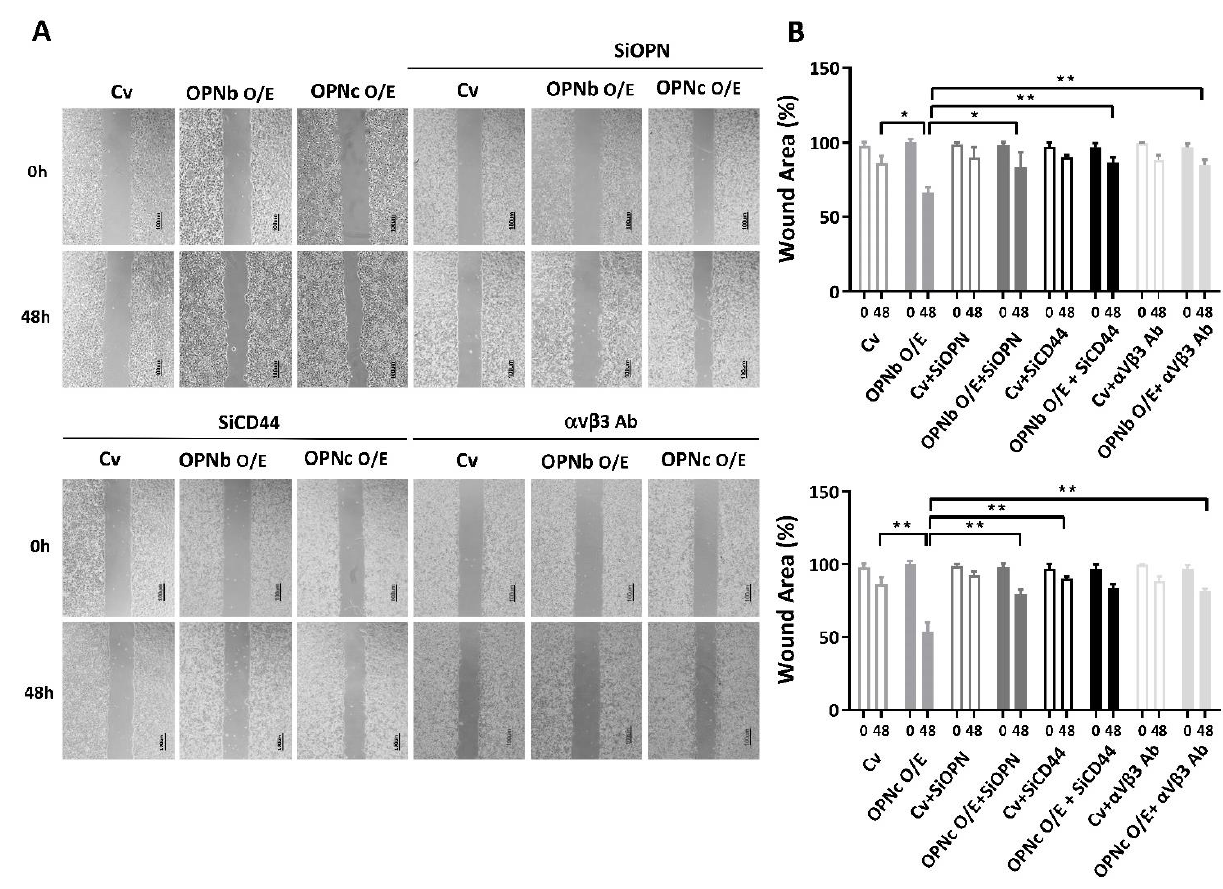
Figure 6. The effect of OPN isoforms on HEC1A cell migration. ( A ) Both OPNb and OPNc promoted cellular migratory ability, but the latter showed a significantly higher stimulation of endometriotic cell migration. Knockdown OPN or suppression of OPN ligand receptors ( α v β 3 and CD44) reversed the changes in the wound healing area. ( B ) Plots show the differences in migration between control cells and OPN-overexpressing cells before and after suppression. Plots represent the mean ± SEM, n = 4. Cv: control vector, O/E: overexpression, si: siRNA, αVβ3 Ab: anti - αVβ3 integrin antibody. ( * ) indicates a significant difference with p < 0.05. ( ** ) indicates a significant difference with p < 0.01.